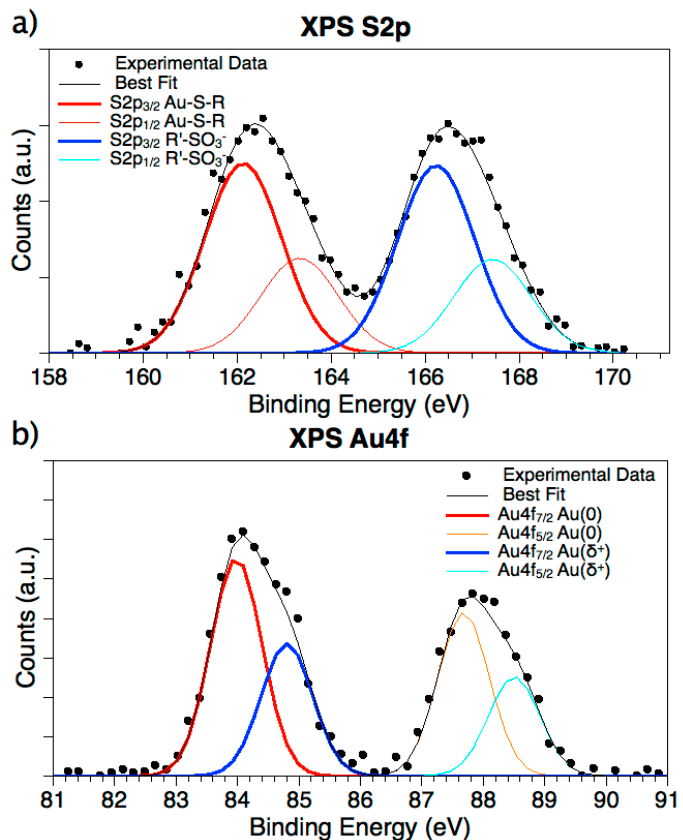
Figure 4. XPS spectra of Au-3MPS@sPEEK. ( a ) XPS S2p spectrum; two signals (each one composed by two spin orbit components: S2p 3/2 and S2p 1/2 ) associated with S atoms bonded to gold atoms at the NP surface (S2p 3/2 red, S2p 1/2 orange), and to sulphonate moieties (S2p 3/2 blue, S2p 1/2 cyan), are observed; ( b ) Au4f spectrum; two signals (each one composed by two spin orbit components: Au4f 7/2 and Au4f 5/2 ) associated with metallic gold atoms at the bulk of NPs (Au4f 7/2 red, Au4f 5/2 orange), and Au atoms bonded to sPEEK through sulfur (Au4f 7/2 blue, Au4f 5/2 cyan), are observed.